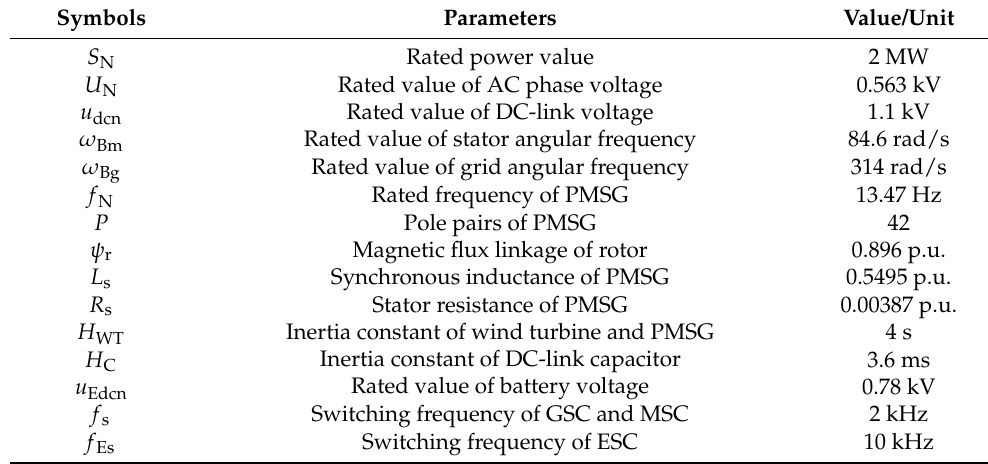
Table 1. Parameters of the wind turbine